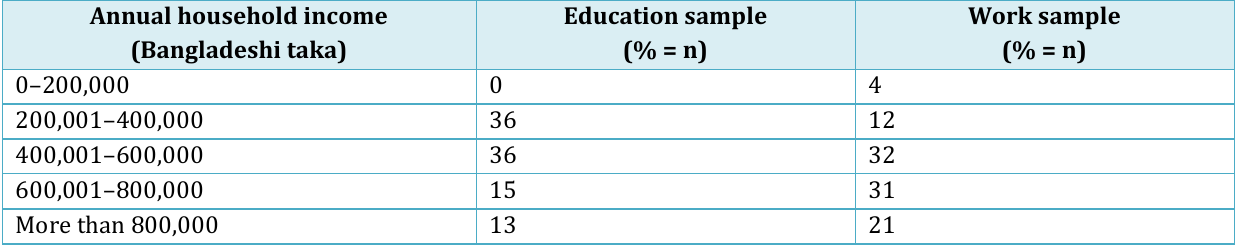
Table 1. Distribution of annual household